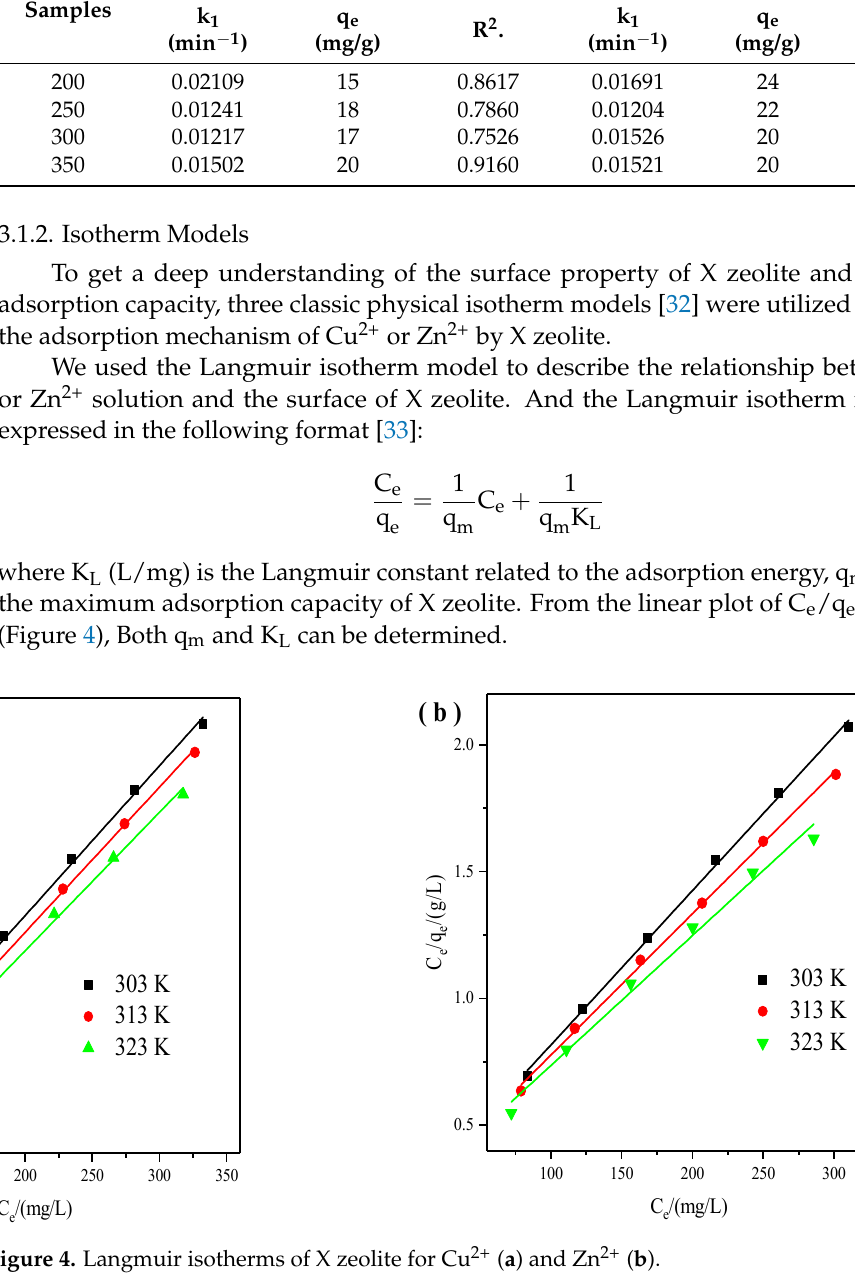
Figure 4. Langmuir isotherms of X zeolite for Cu 2+ ( a ) and Zn 2+ ( b ).